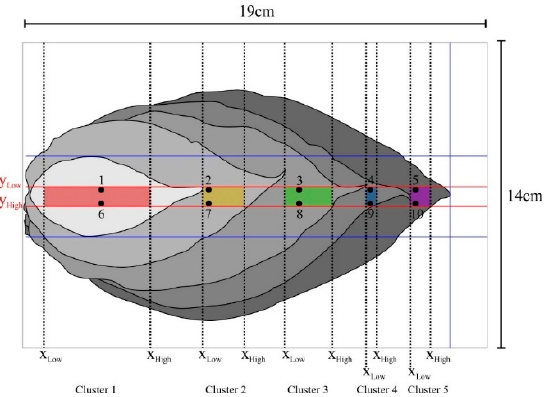
Figure 10. Designed system of image processing based on RGB color by ten pixel points. Table 2. Vertical boundaries for the five grades.